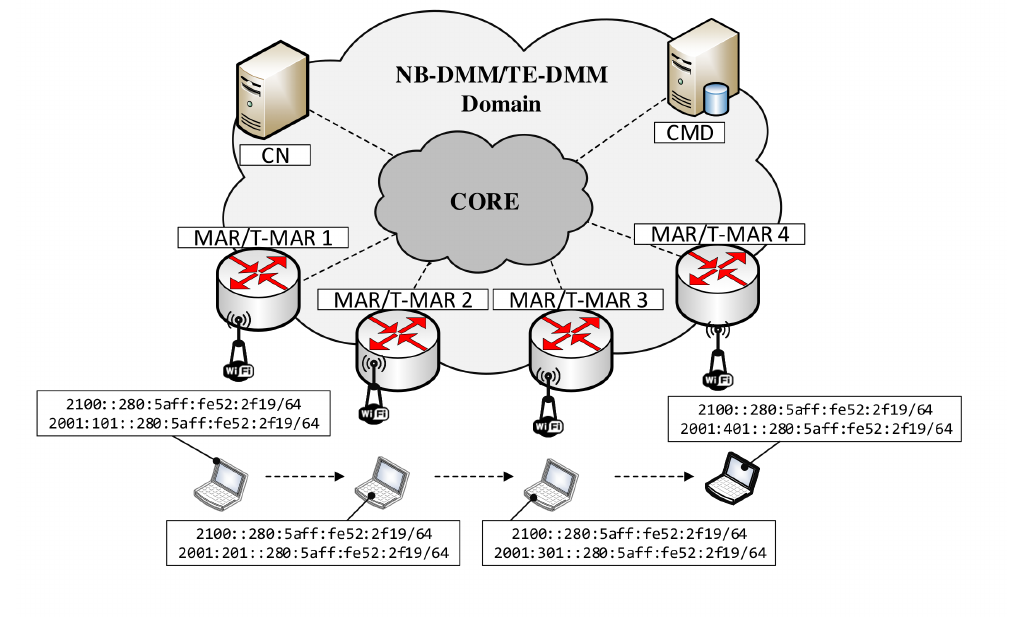
Figure 10. Testbed used in experimental